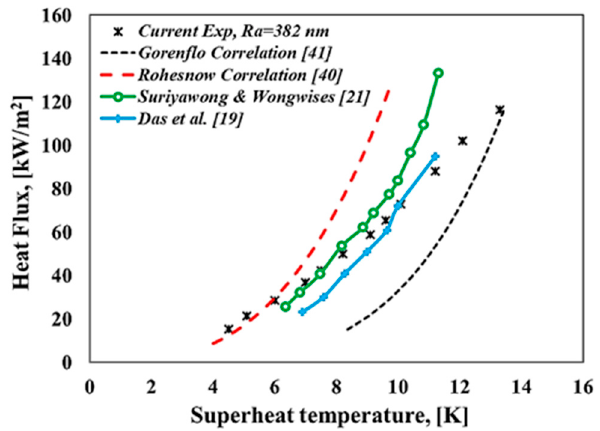
Figure 5. Boiling curves for present experimental research and literature studies.